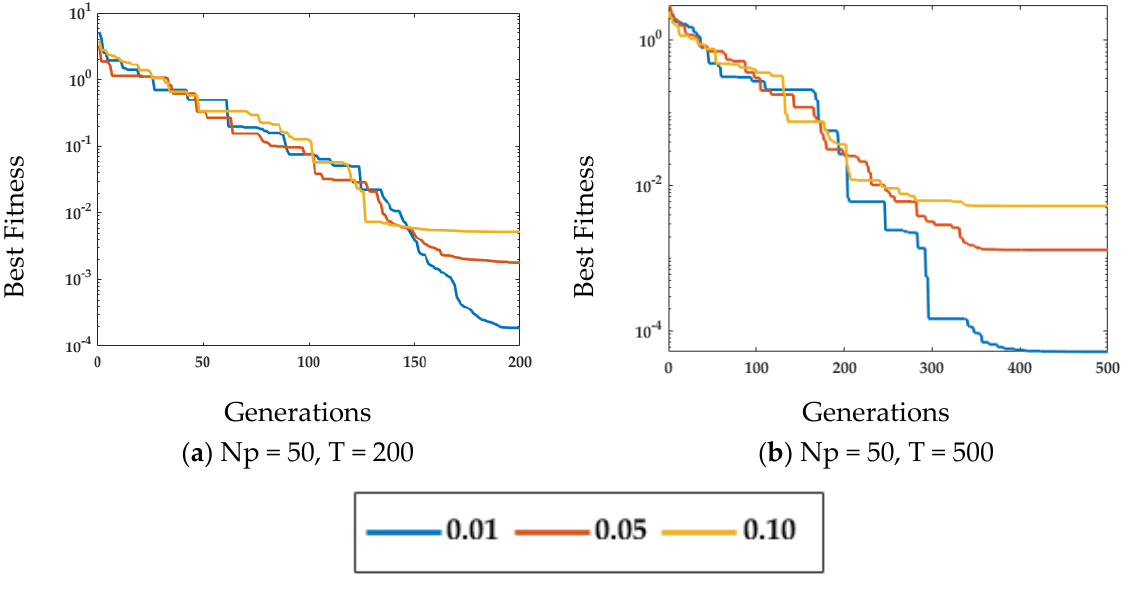
Figure 9. Fitness plots for MPA w.r.t noise levels for case study 2.